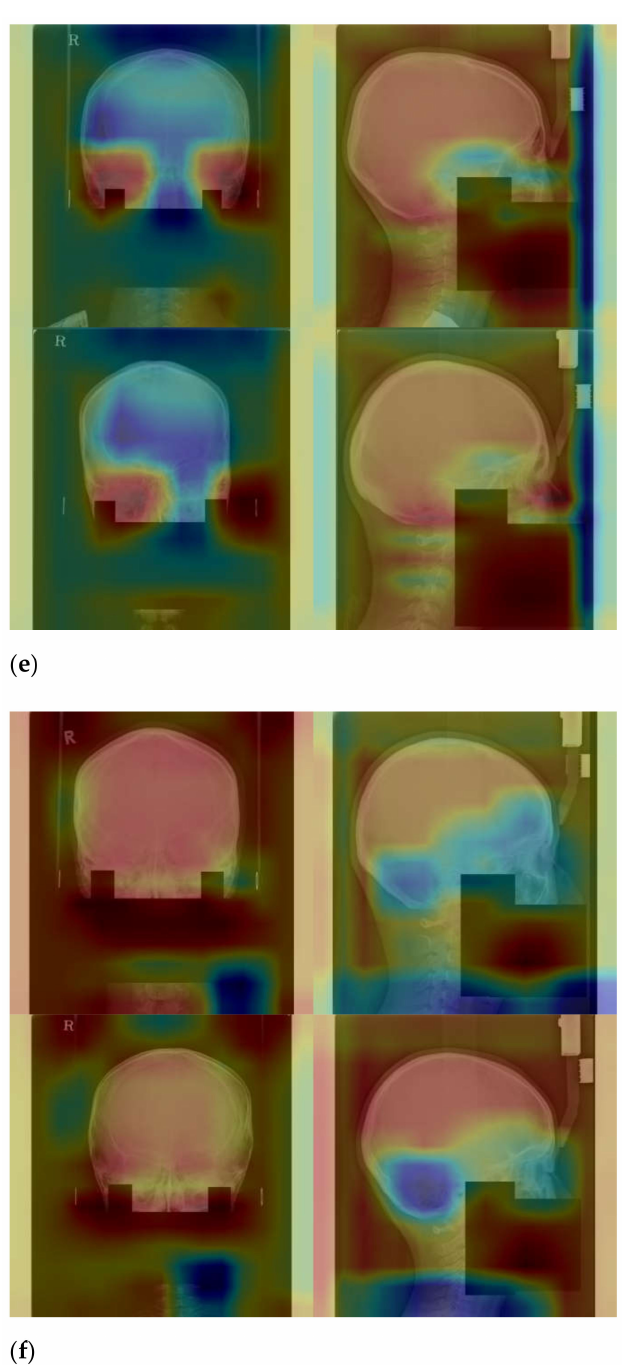
Figure 7. CAM of PA and lateral cephalometric images for ( a ) Class I of test 1, ( b ) Class II of test 1, ( c ) Class III of test 1, ( d ) Class I of test 2, ( e ) Class II of test 2, and ( f ) Class III of test 2. Class I: normal mandible; Class II: retrognathism; and Class III: prognathism. The greater the activation, the redder it is; the greater inactivation, the bluer it